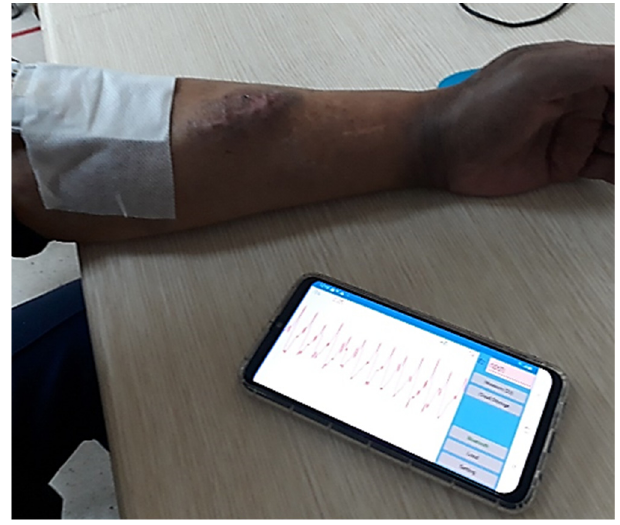
Figure A1. Placement of the arm with the AVF to be tested.